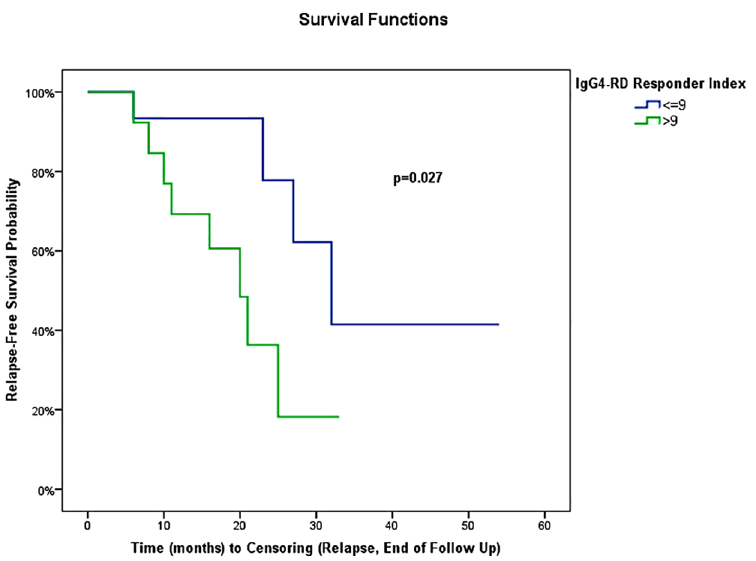
Fig 2. Kaplan-Meier plots of the risk of disease relapse following rituximab for patients with IgG4-RD RI > 9 and with IgG4-RD RI (cid:20) 9 at RTX treatment. IgG4-RD RI, IgG4-related disease Responder Index.